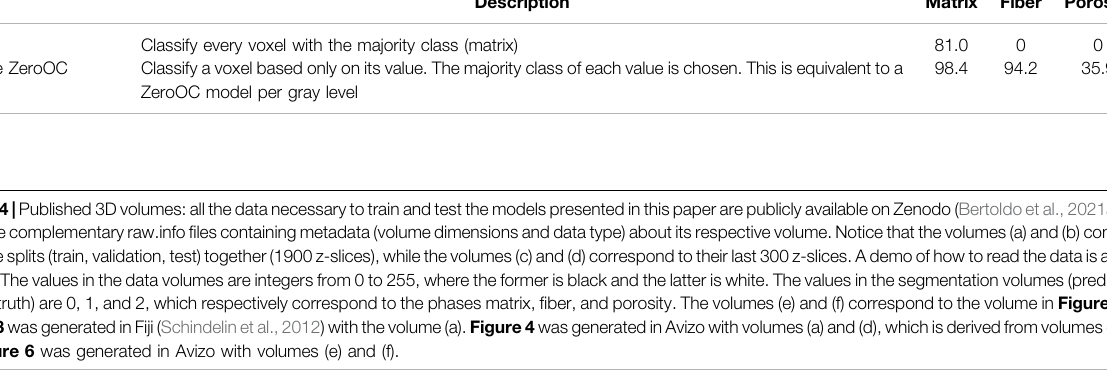
TABLE 3 | Expected performance of baseline theoretical models in terms of class-wise Jaccard index (%). Model